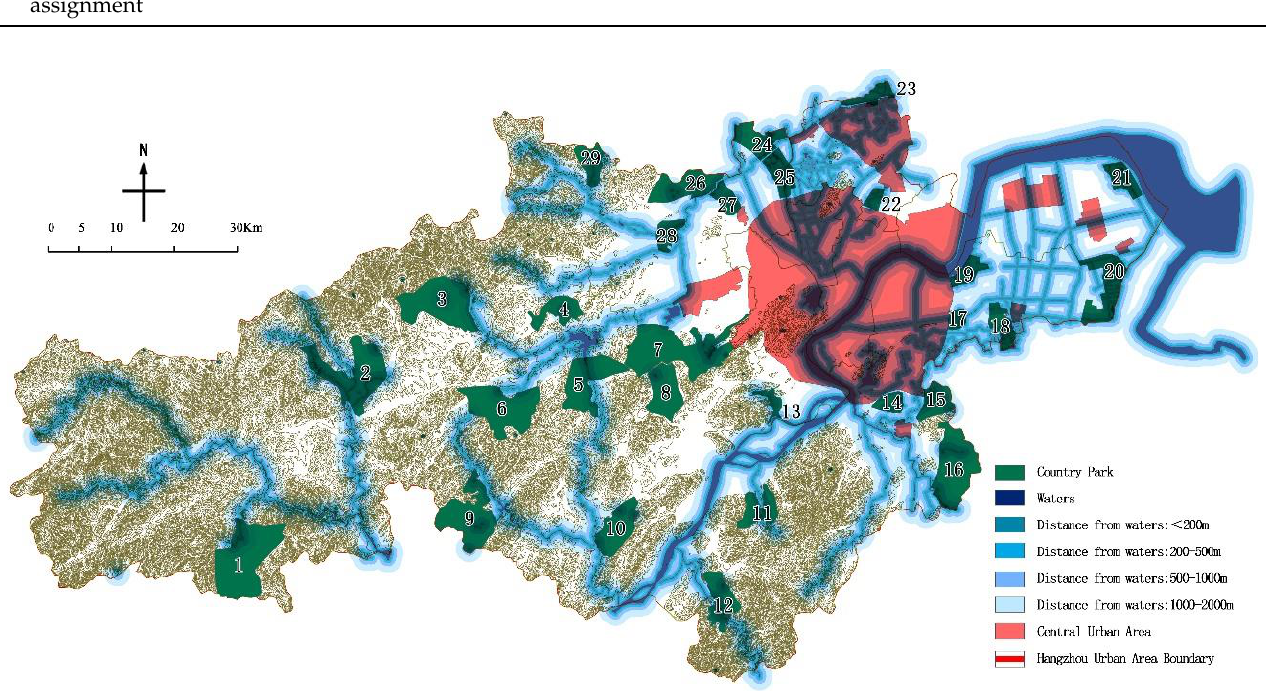
Figure 7. Distances of country parks from waters.